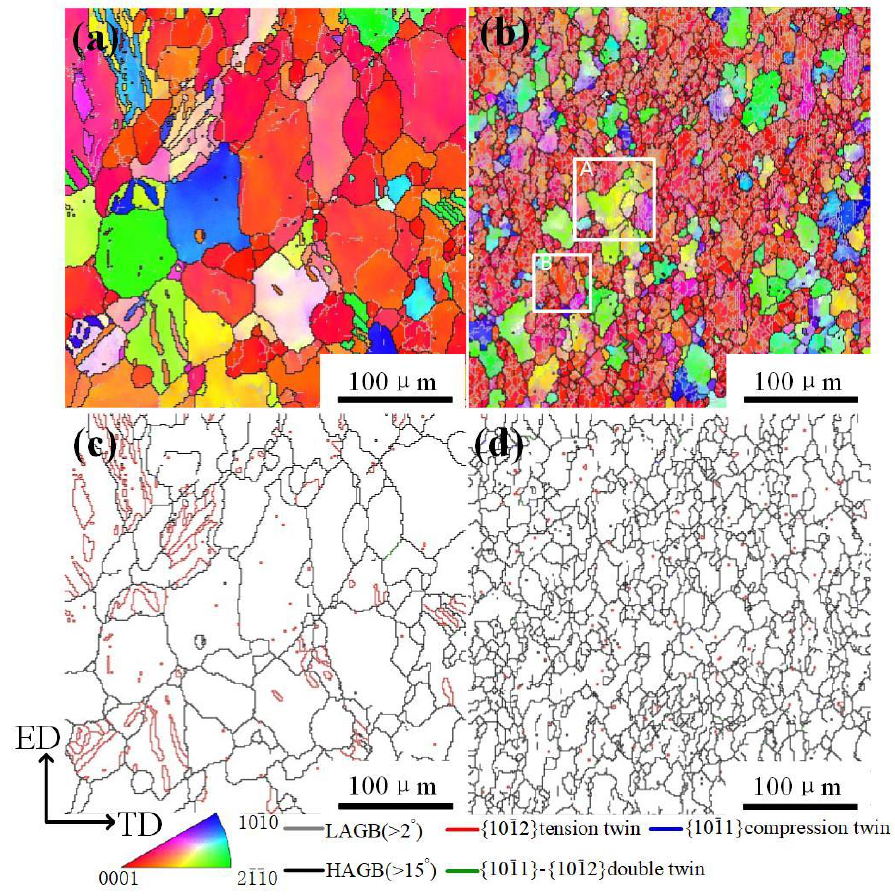
Figure 5. ( a , b ) IPF images and ( c , d ) twin distribution of ( a , c ) the initial sample and ( b , d ) the final sample under 30 A/mm 2 .